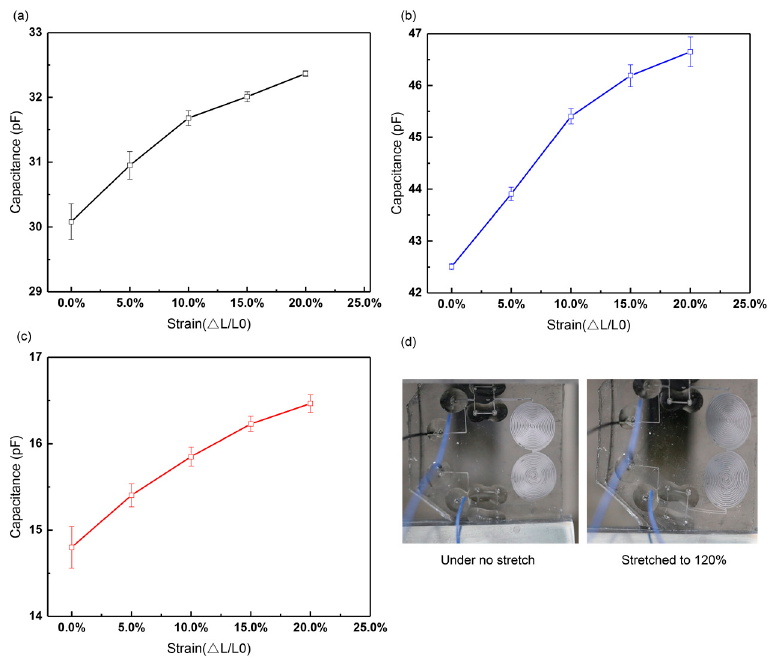
Figure 11. Strain response curves of leakage-free electrode-based ( a ) Sensor A, ( b ) Sensor B, and ( c ) Sensor C; ( d ) stretchable sensors under stretch.